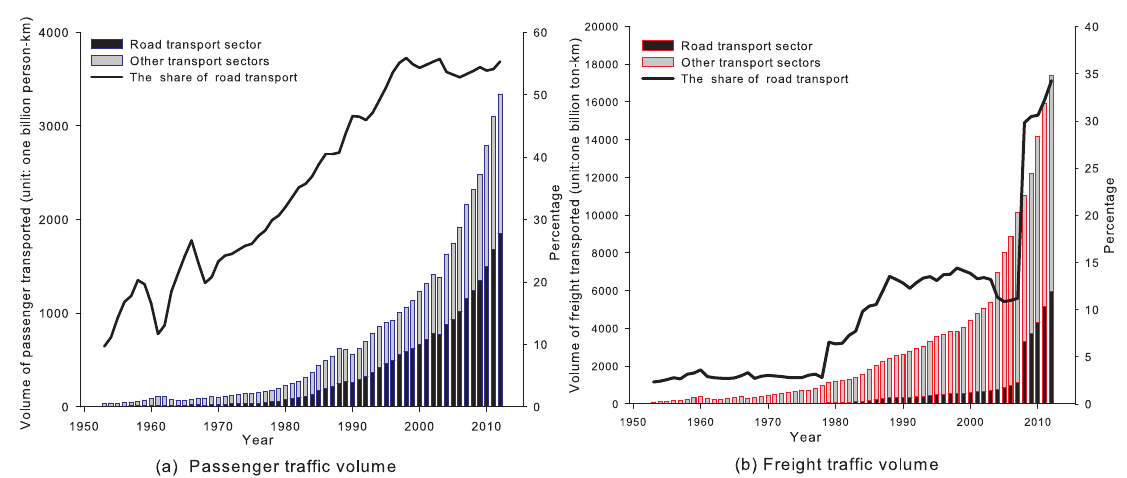
Figure 3. The freight and passenger traffic volumes in China (data source: NBSC, http://data.stats.gov. cn/index).